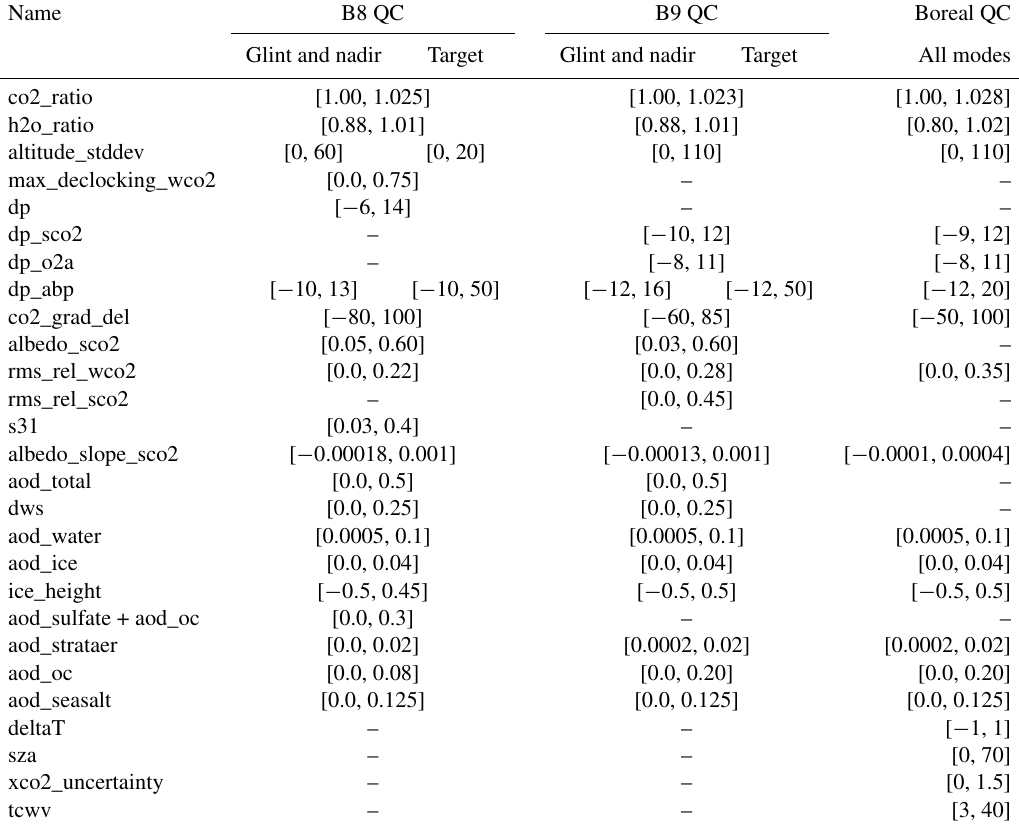
Table 1. Quality control thresholds currently used to determine the B8 QC (xco2_quality_flag_b8=0 in OCO-2 Lite files), B9 QC (xco2_quality_flag=0 in OCO-2 Lite files), and boreal QC (new proposed thresholds for terrestrial high-latitude sites). Descriptions of QC parameters in this table can be found in Table S2 or Osterman et al.